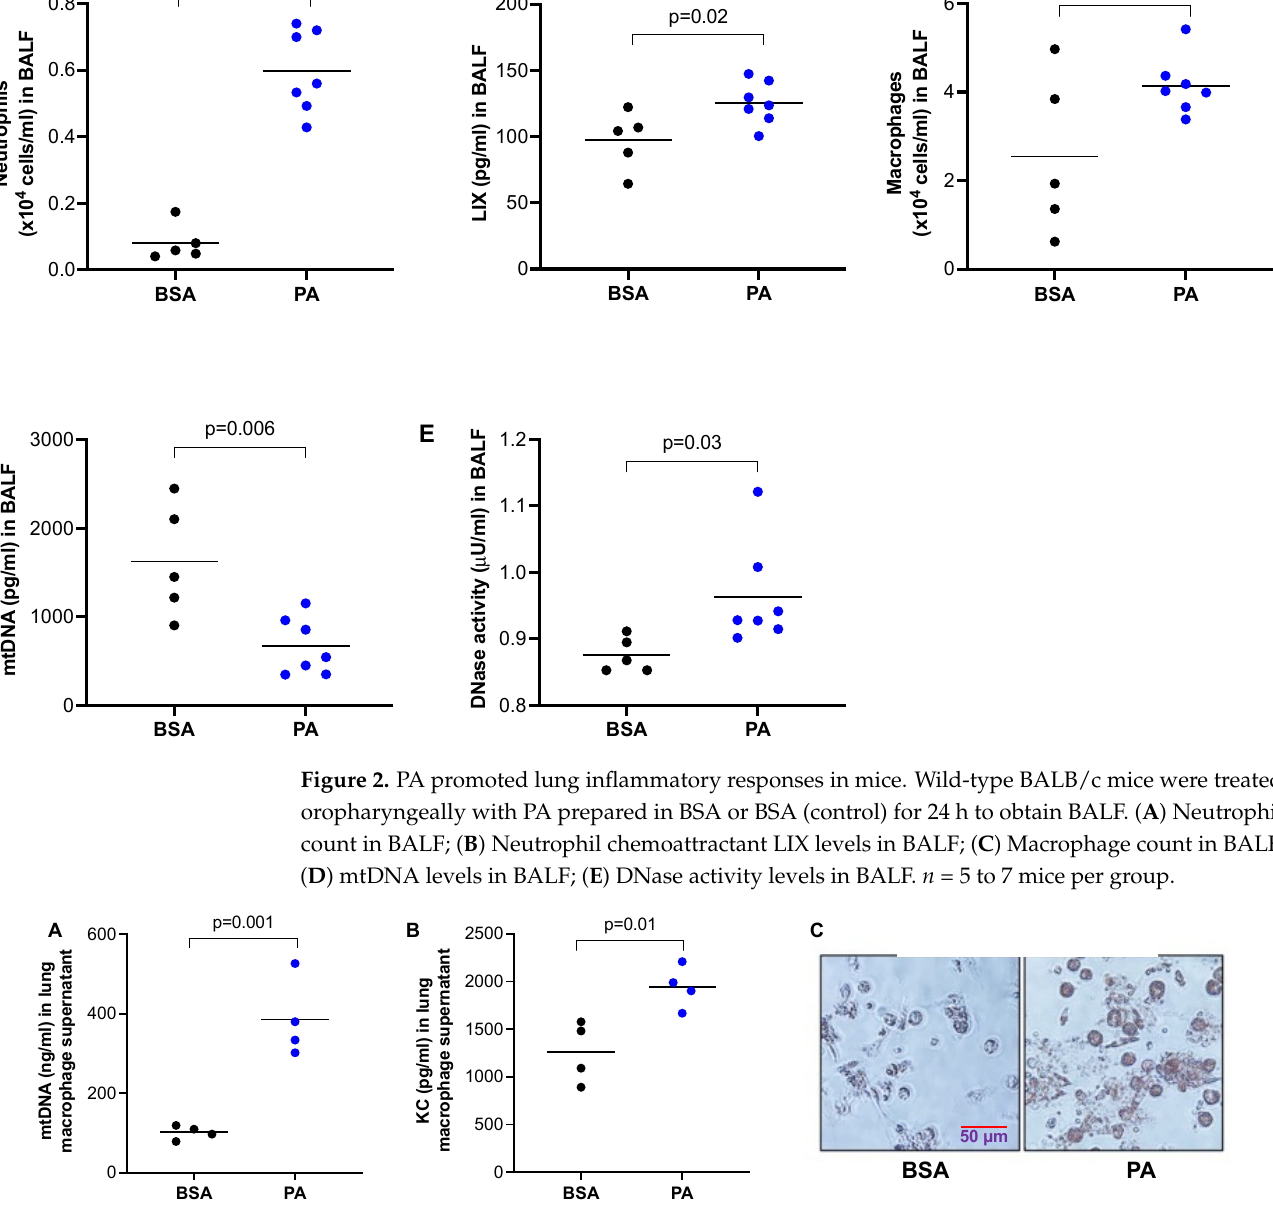
Figure 3. PA enhanced mtDNA and pro-inflammatory cytokine release from lung macrophages. Lung macrophages isolated from wild-type C57/BL6 mice were cultured and treated with PA (1 mM) and prepared in 0.1% BSA or 0.1% BSA (control) for 24 h to obtain the supernatants for